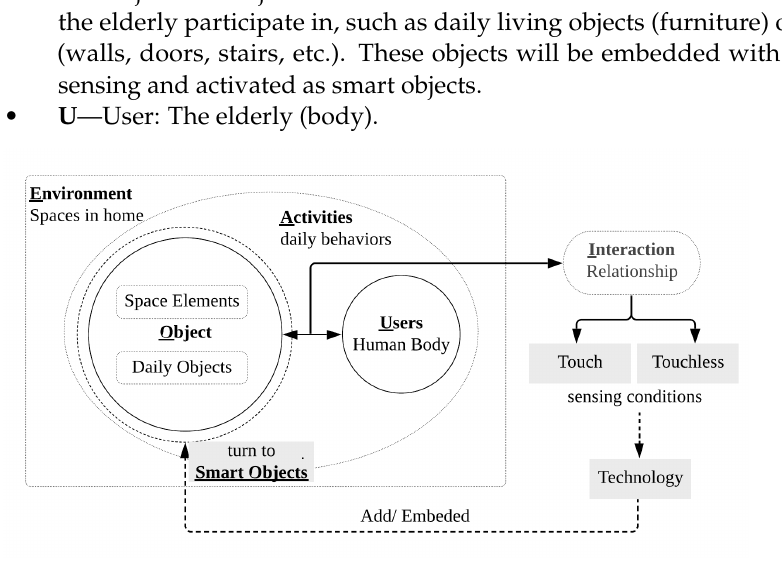
Figure 1. The A.E.I.O.U framework diagram.